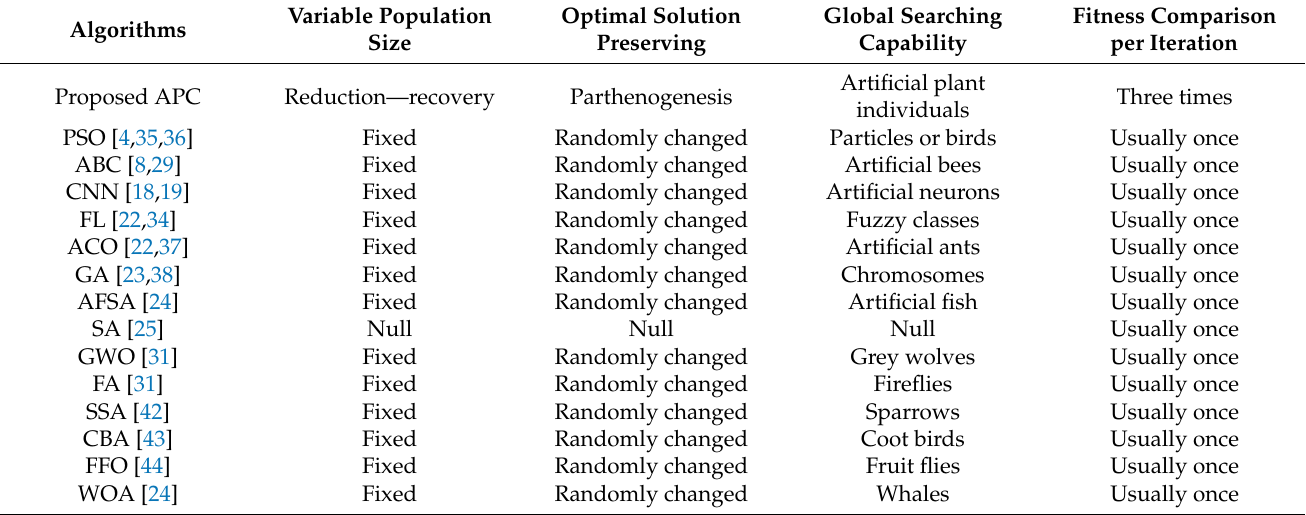
Table 7. Theoretical comparison for positioning